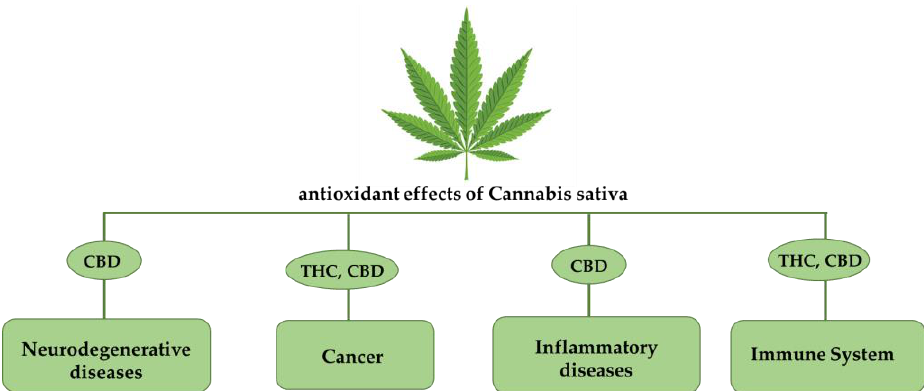
Figure 1. Schematic representation of the antioxidant effects of Cannabis sativa derivatives. Both of the two main phytocannabinoids, THC and CBD, have been found to be beneficial to different classes of pathologies owing to their antioxidant effects.